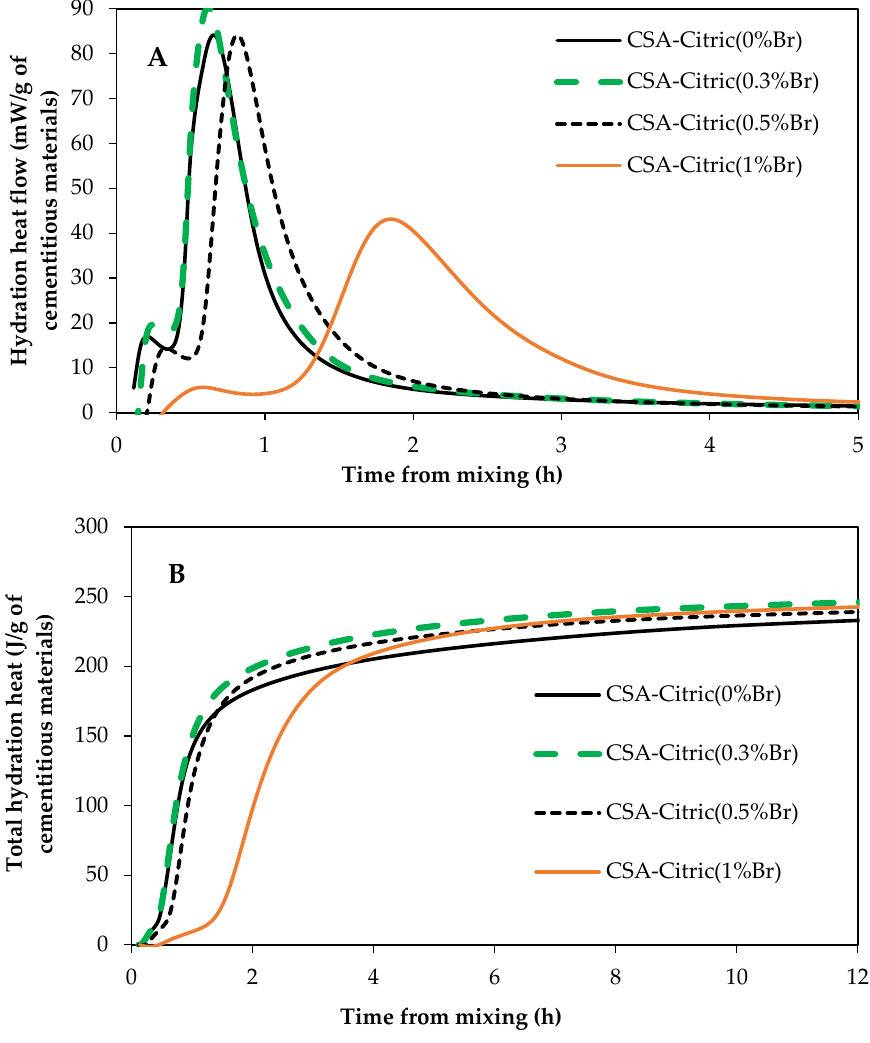
Figure 11. Influence of borax on CSA hydration; ( A ) heat flow and ( B ) total hydration heat .